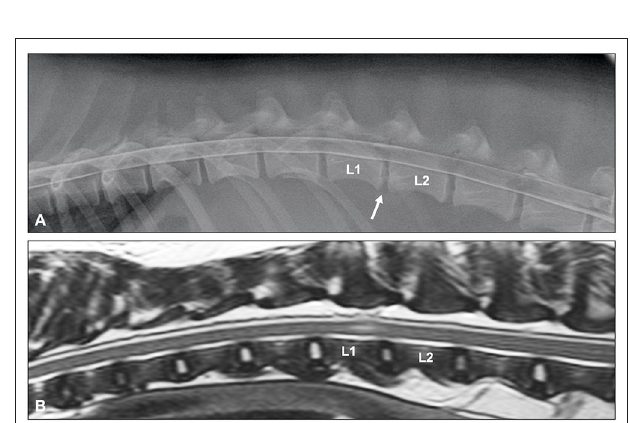
FIGURE 10 | Lateral myelogram (A) and sagittal T2-weighted image (B) of a 4-year old Soft-Coated Wheaten terrier with an L1-L2 ANNPE. (A) Although the L1-L2 intervertebral disc space is narrowed (arrow), the myelographic pattern appears to be normal. (B) A focal intramedullary hyperintense lesion just cranial from the L1-L2 disc space can be observed. The homogenously hyperintense nucleus pulposus has a reduced volume and the intervertebral disc space is